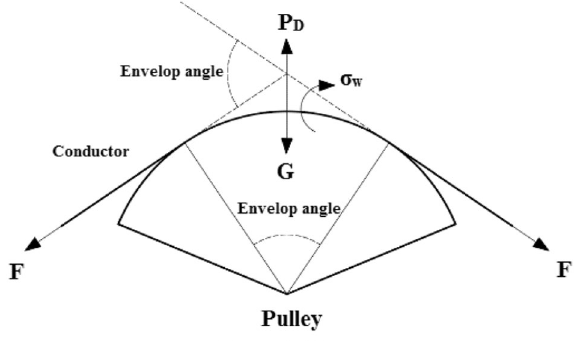
Figure 1. Force diagram of conductor passing through